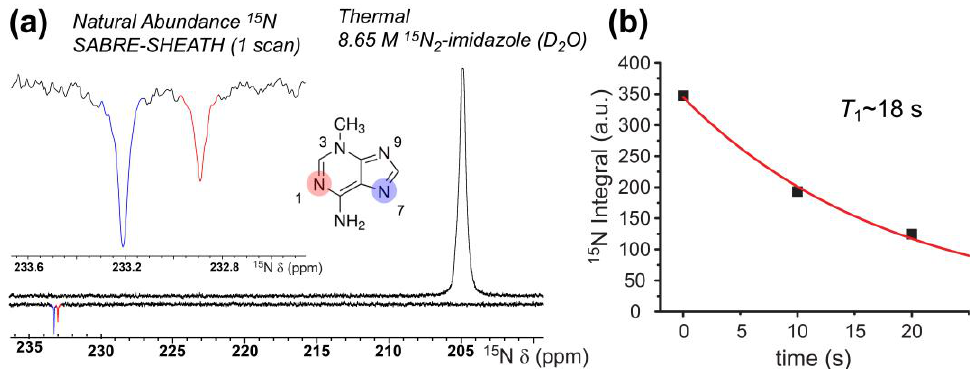
Figure 7. ( a ) Natural-abundance 15 N SABRE-SHEATH of 40 mM 3-methyladenine ( bottom ) reveals ε values of ~3300 ( 15 N A ) and ~1900 ( 15 N B ), respectively, when compared to a thermally polarized signal from a 15 N 2 -imidazole reference sample ( top ); a close-up of the enhanced resonances is shown in the inset . Tentative 15 N shift assignments were made in light of Refs. [72–74]. ( b ) Hyperpolarization decay curve obtained from single-point acquisitions with varying delay at 9.4 T prior to acquisition (the fit was constrained by including a fourth point set to zero at 1000 s).